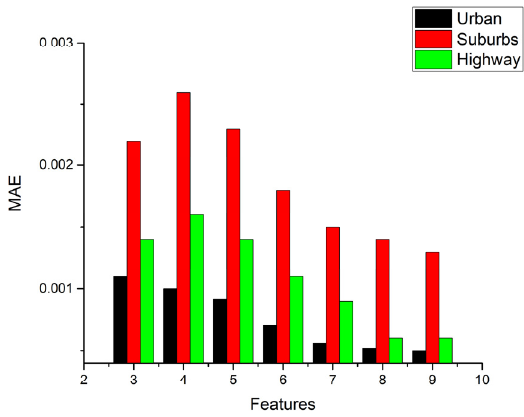
Figure 9. Performance MAE statistics results of CO 2 model.